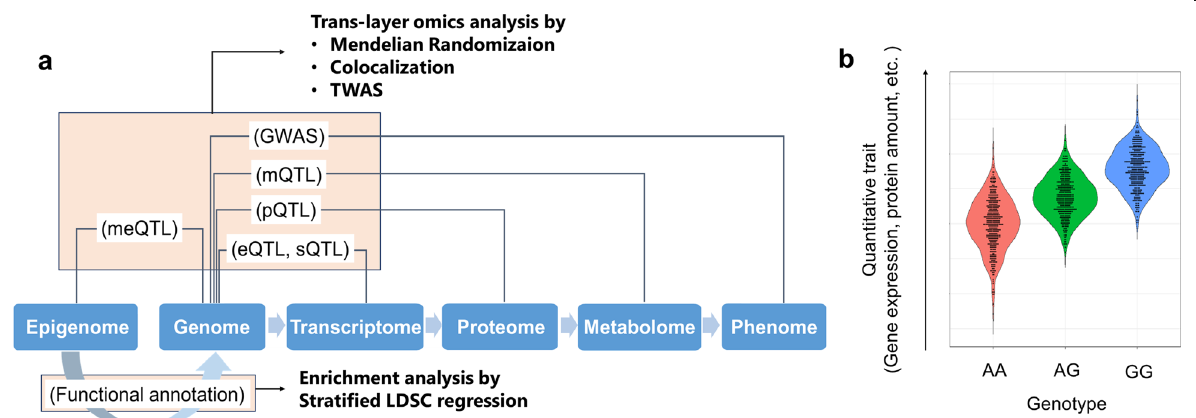
Fig. 1 Overview of trans-omics layer analysis. a Omics data constituting each layer of the central dogma and analysis methods that combine them. GWASs show associations between genotype and phenotype. Quantitative trait loci (QTL), which reflect how much genetic variants affect data in other layers, can link genome to other omics. Epigenetic data provide functional genomic annotations based on various experiments. These data connecting each layer are described in red squares and analysis methods that integrate them are shown in bold. GWAS: genome-